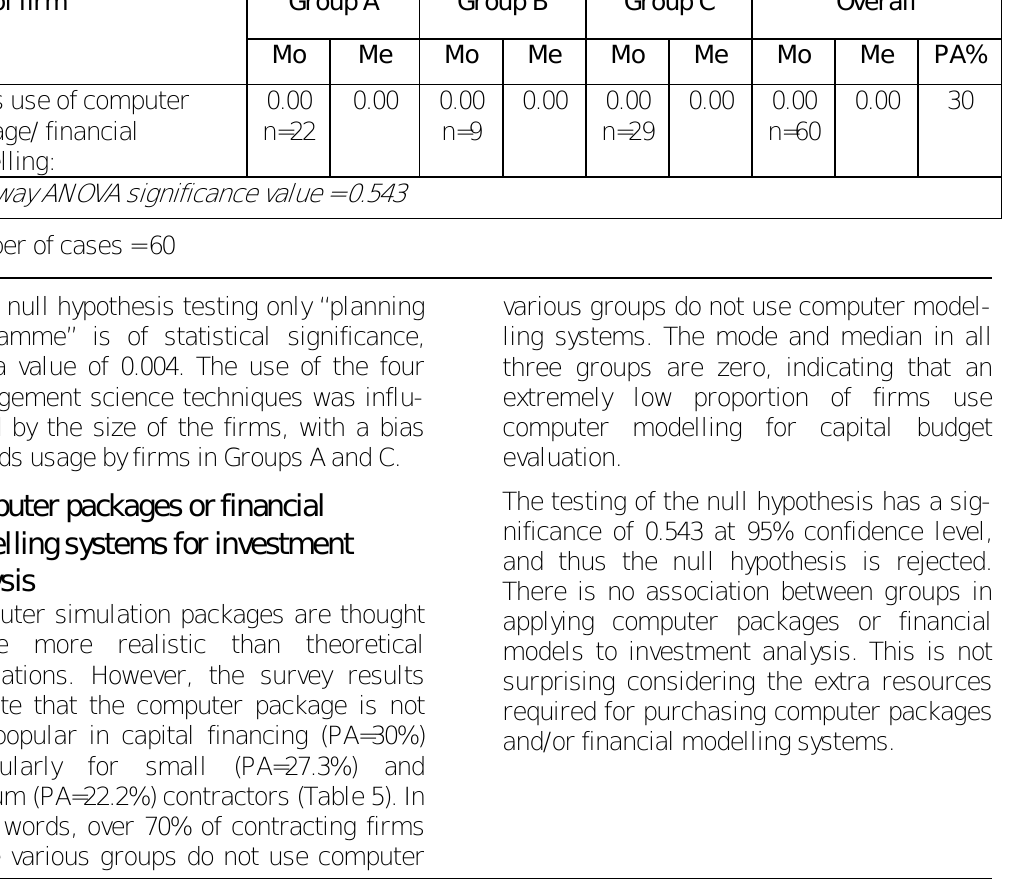
Table 5: Comparisons of the usage of computer packages or financial modelling systems Size of firm Group A Group B Group C